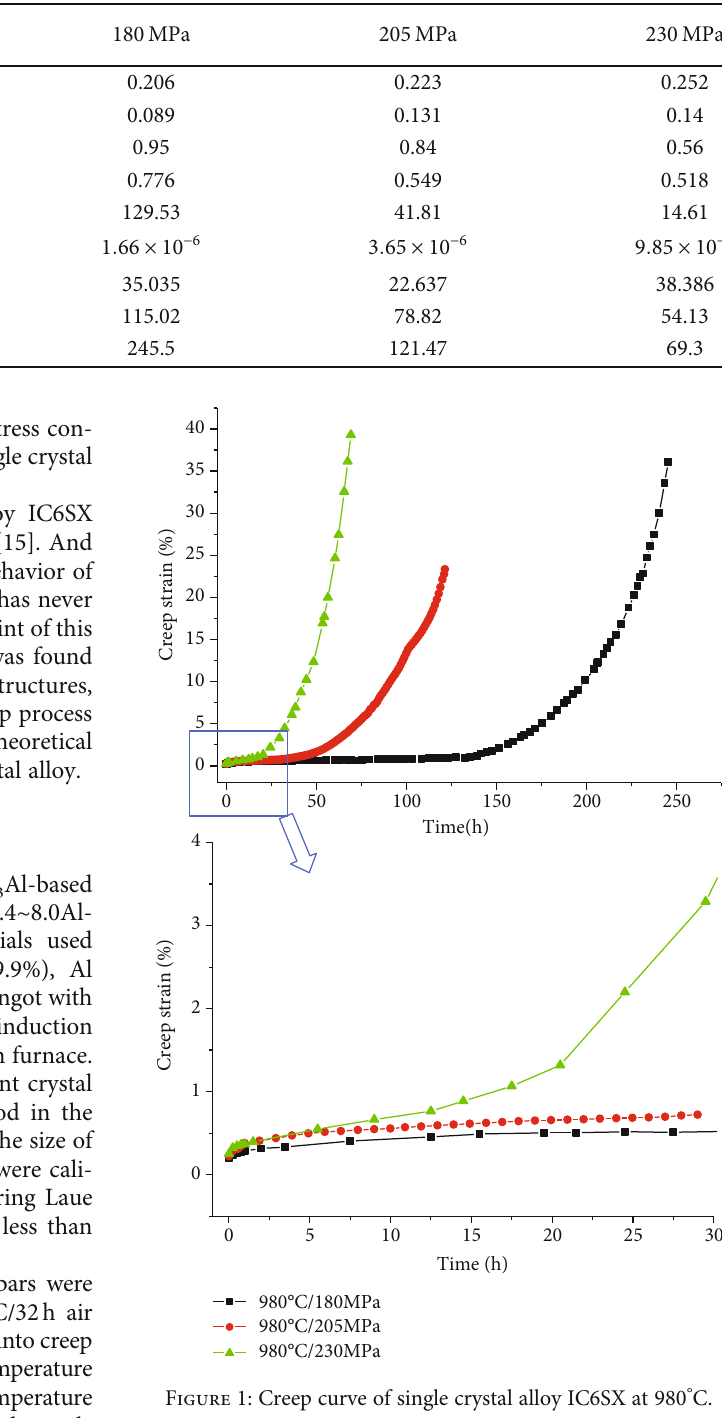
Table 1: Creep properties of single crystal alloy IC6SX at 980 ° C.